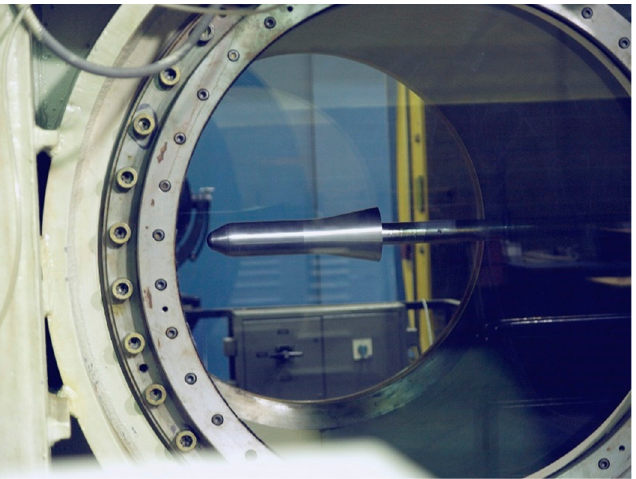
Figure 9. The 75 mm diameter HB-2 model in the test section of the T-38 wind tunnel